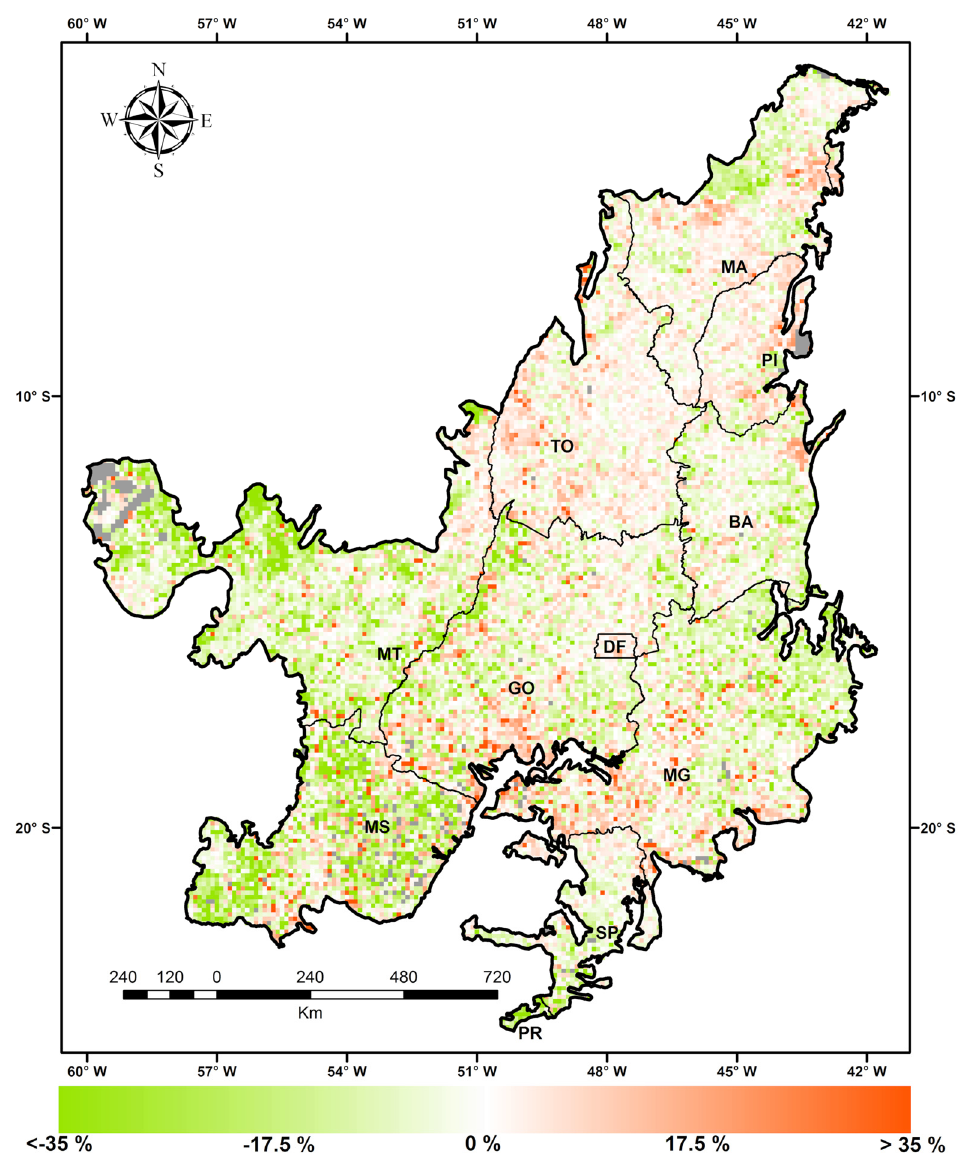
Figure 7. Annual trend (%) calculated as the average slope from the 10,000 bootstrap iterations with respect to the average PM 2.5 fire emissions in the Cerrado biome. Annual trend is based on PREP-CHEM-SRC 1.8.3 estimates when considering the 2002–2017 period. Gray pixels presented zero PM 2.5 emission associated with fires during the entire 2002–2017 period.